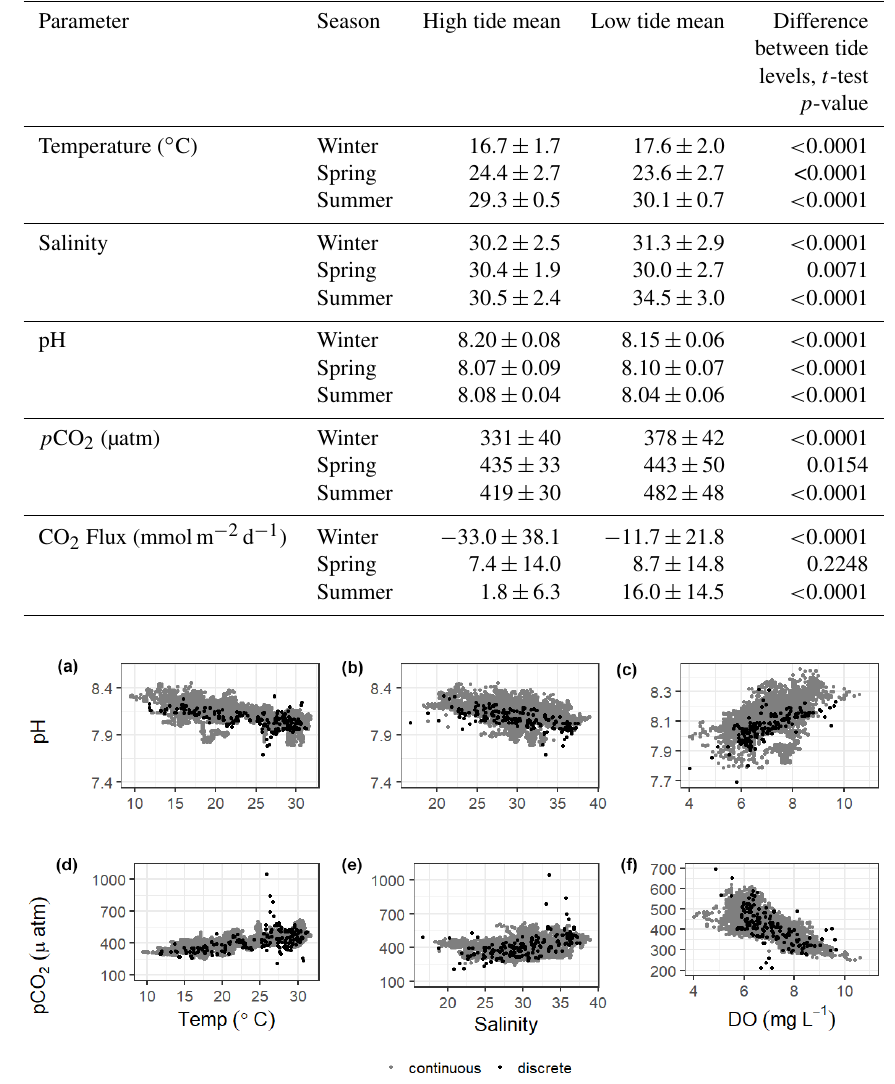
Table 2. Mean and standard deviation of temperature, salinity, pH, p CO 2 , and calculated CO 2 flux (from continuous sensor measurements) during high and low tide conditions.